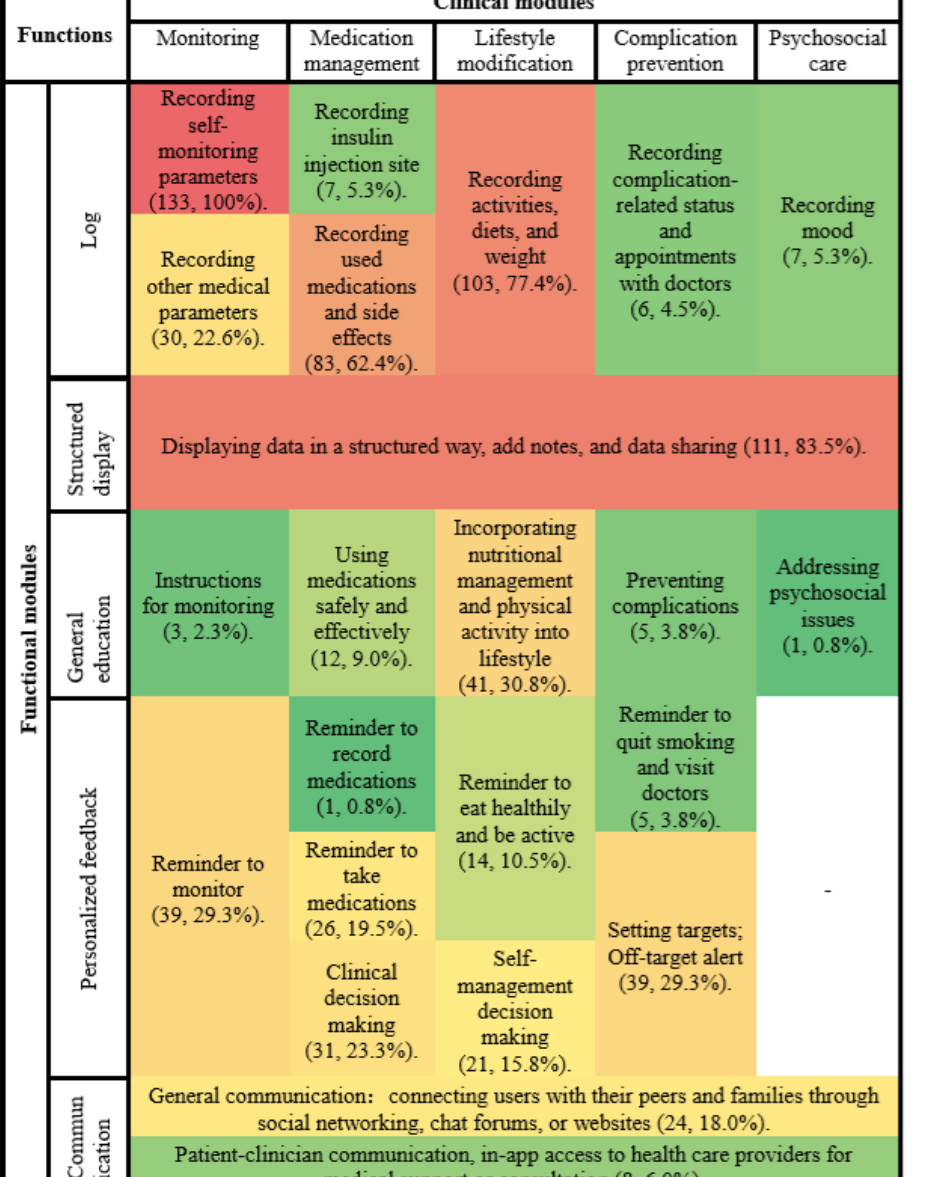
Figure 3. Heatmap of features of 133 US mobile apps for diabetes self-management.